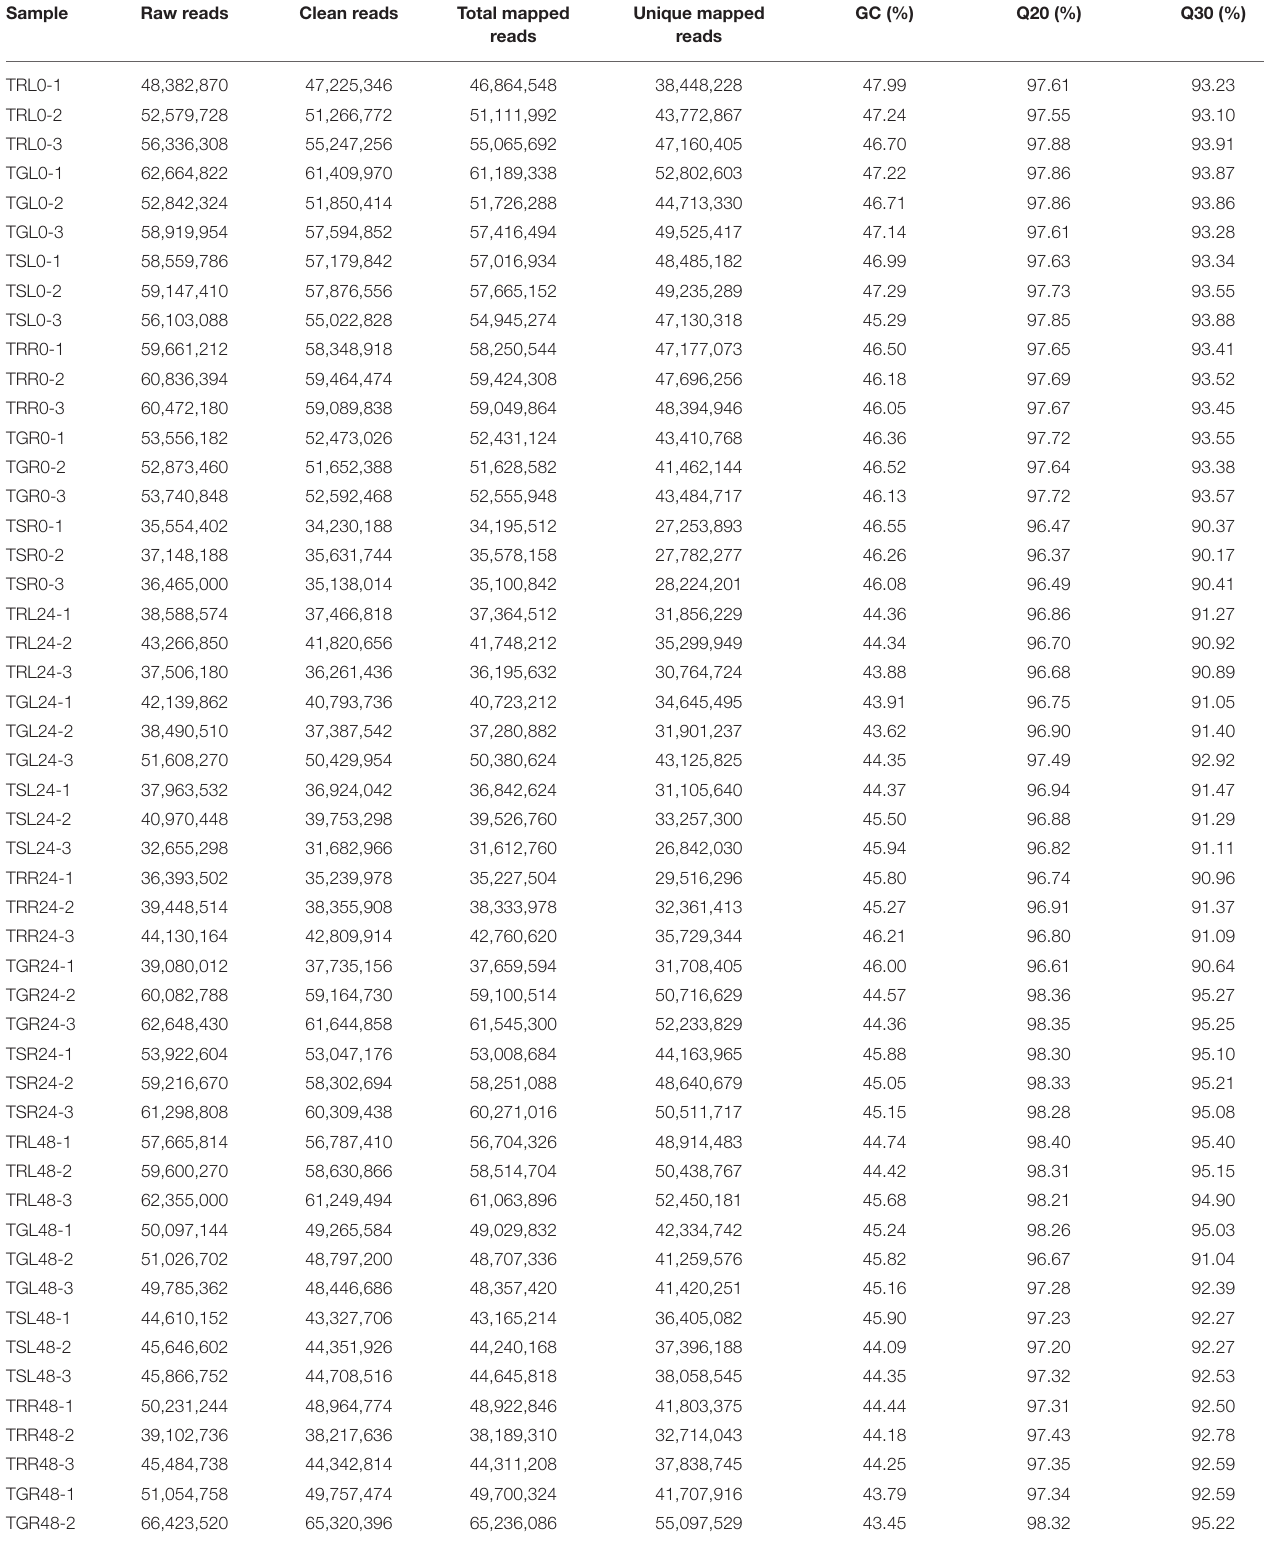
TABLE 1 | A summary of current transcriptome results.